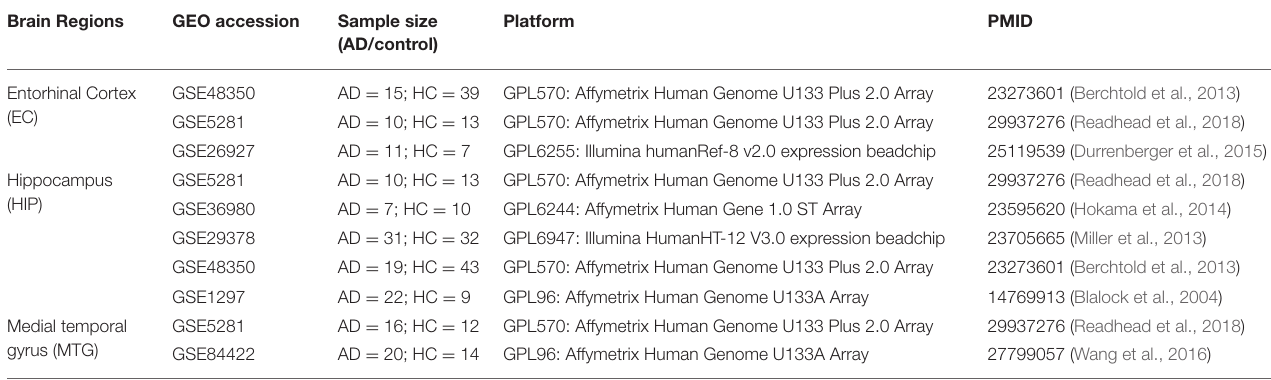
TABLE 1 | Datasets used in the meta-analysis.